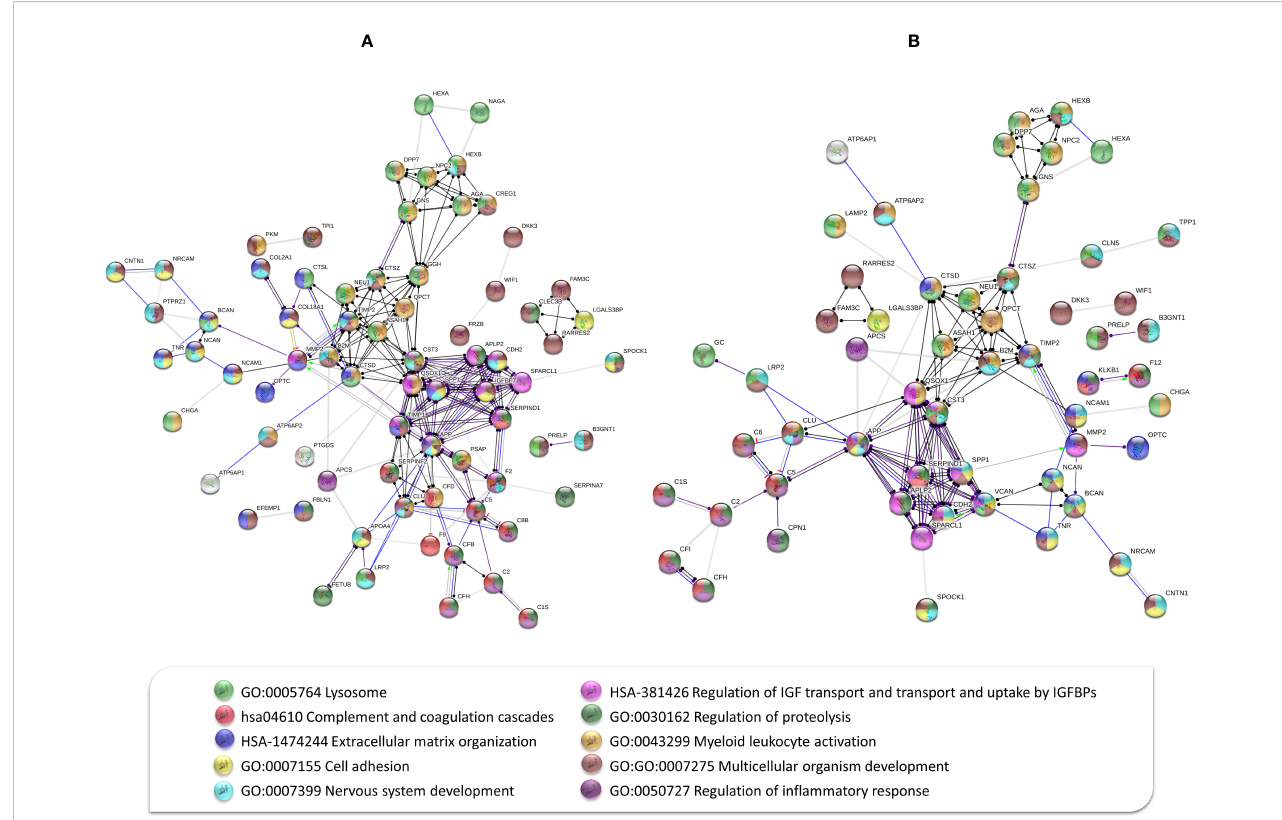
FIGURE 3 Protein-protein interaction network between (A) 118 differentially expressed proteins in proliferative diabetic retinopathy (PDR) versus epiretinal membranes (ERM), and (B) 95 differentially expressed proteins in PDR versus dry age-related macular degeneration based on molecular action with high con fi dence (0.70). Some biological processes/pathways stand out in both interaction networks, including complement and coagulation cascades, lysosomal degradation, cell adhesion, extracellular matrix organization, multicellular organism, and nervous system development, among others, as represented by colored